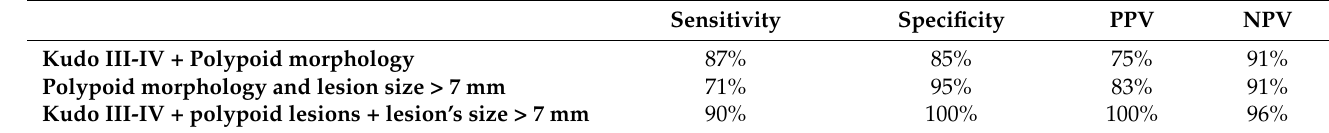
Table 5. Cont. Sensitivity Specificity PPV